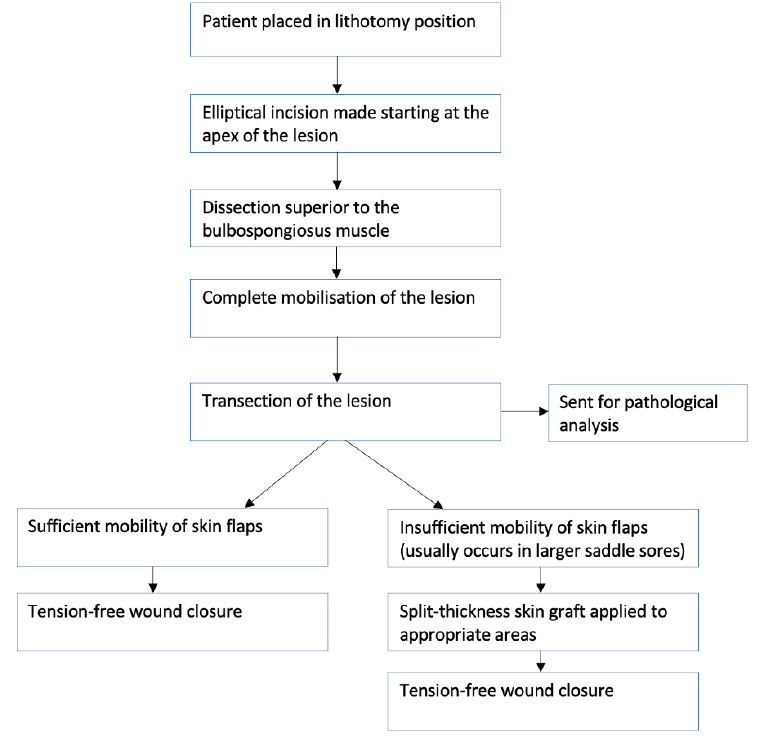
Figure 4. Flow diagram summarising the surgical excision technique reported by Awad et al. [17] in a 48-year-old male cyclist, describing the stages